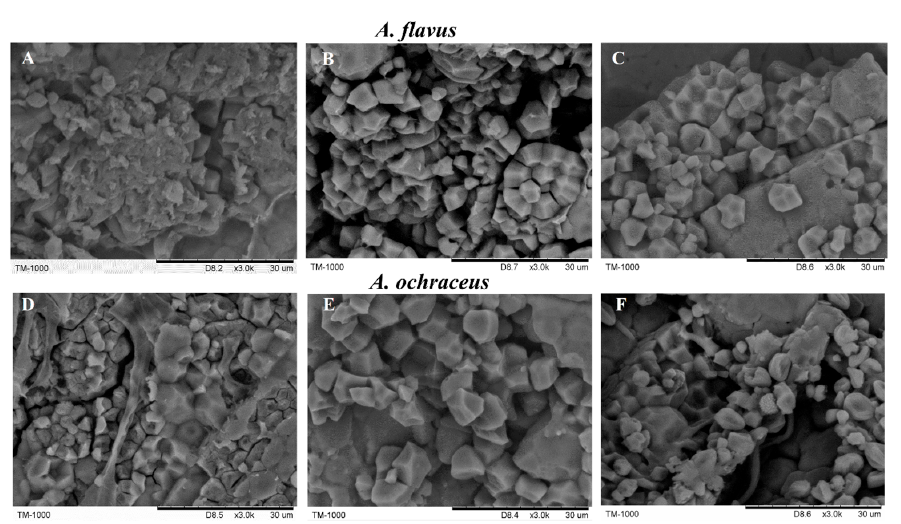
Figure 3. Relative membrane permeability of two toxigenic Aspergillus spp. after treatment for 7 days with control, citral, or geraniol. Data are the mean ± SD of three independent experiments. Columns with different letters at the same group indicate significant difference ( p < 0.05) according to Duncan’s test.